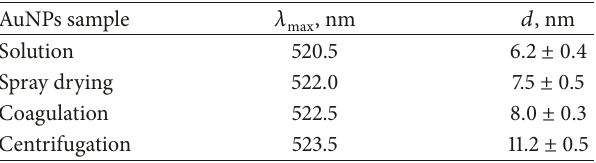
Table 1: The values of 𝜆 max and the size of AuNPs ( 𝑑 ) from AuNPs/dextran solution and powders prepared by different meth-